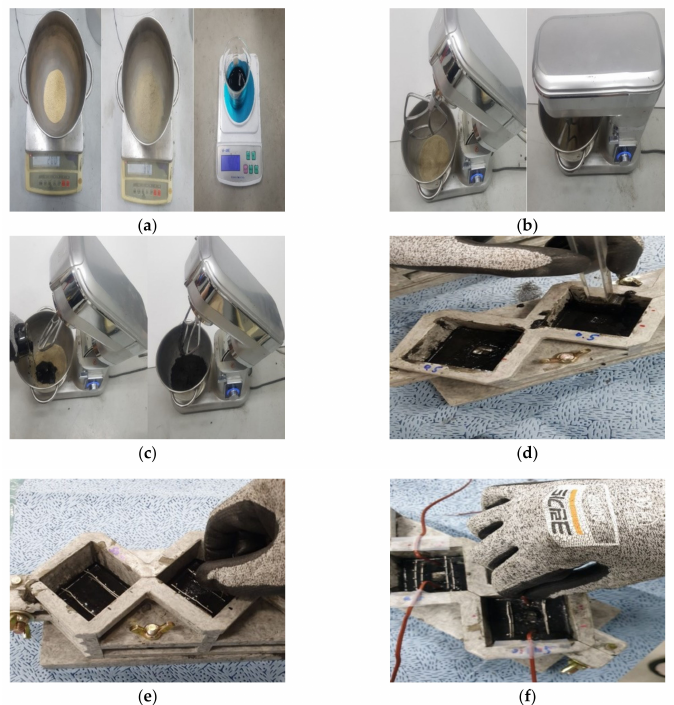
Figure 3. Fabrication process: ( a ) measuring materials, ( b ) dry mixing of cement and sand, ( c ) carbon nanotube (CNT)-solution mixing (3 min), ( d ) compaction, ( e ) insertion of stainless-steel mesh, and ( f ) insertion of thermocouple.